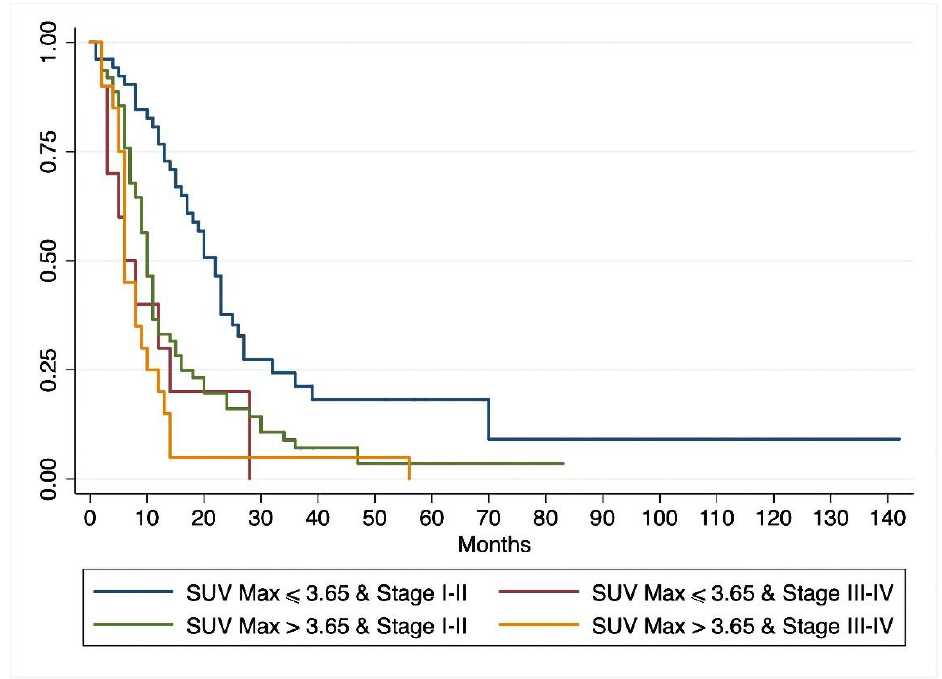
Figure 3. Kaplan–Meyer estimates for disease-free survival based on preoperative tumor stage and high or low SUVmax.